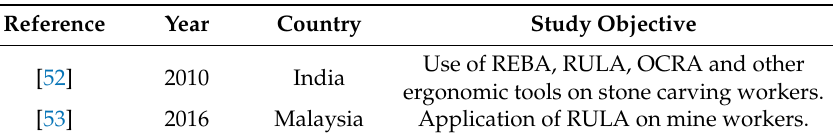
Table 4. Mining and